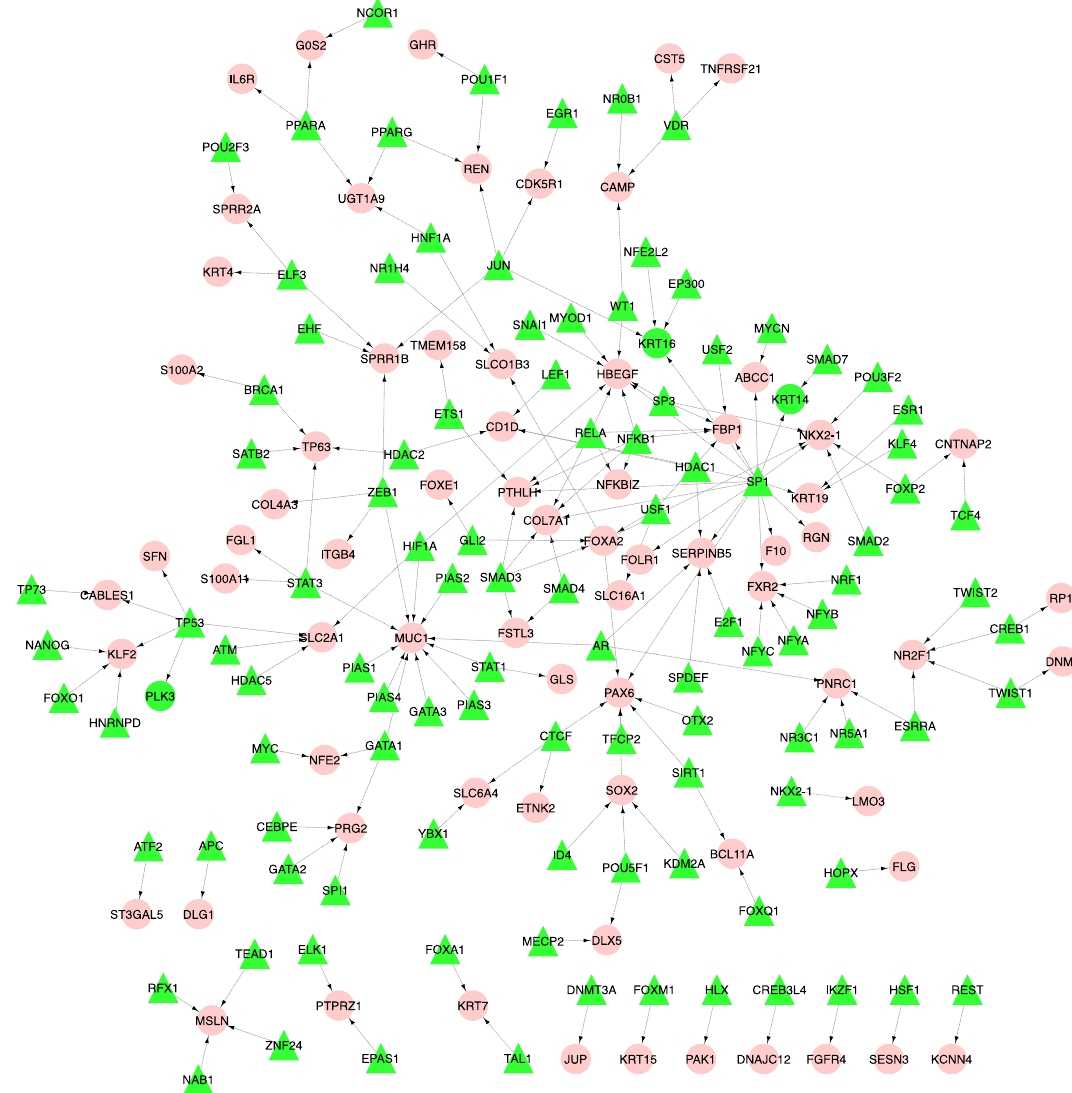
Figure 3. The TF–TG interaction network. This network contains 178 nodes and 182 regulatory interactions. Out of 178 nodes, 107 and 71 nodes are TFs and TGs, respectively. All of the TG nodes are from the magenta and purple modules. The red circles and green triangles represent TGs and TFs, respectively (this figure was drawn in the Cytoscape 43 v.3.8.2